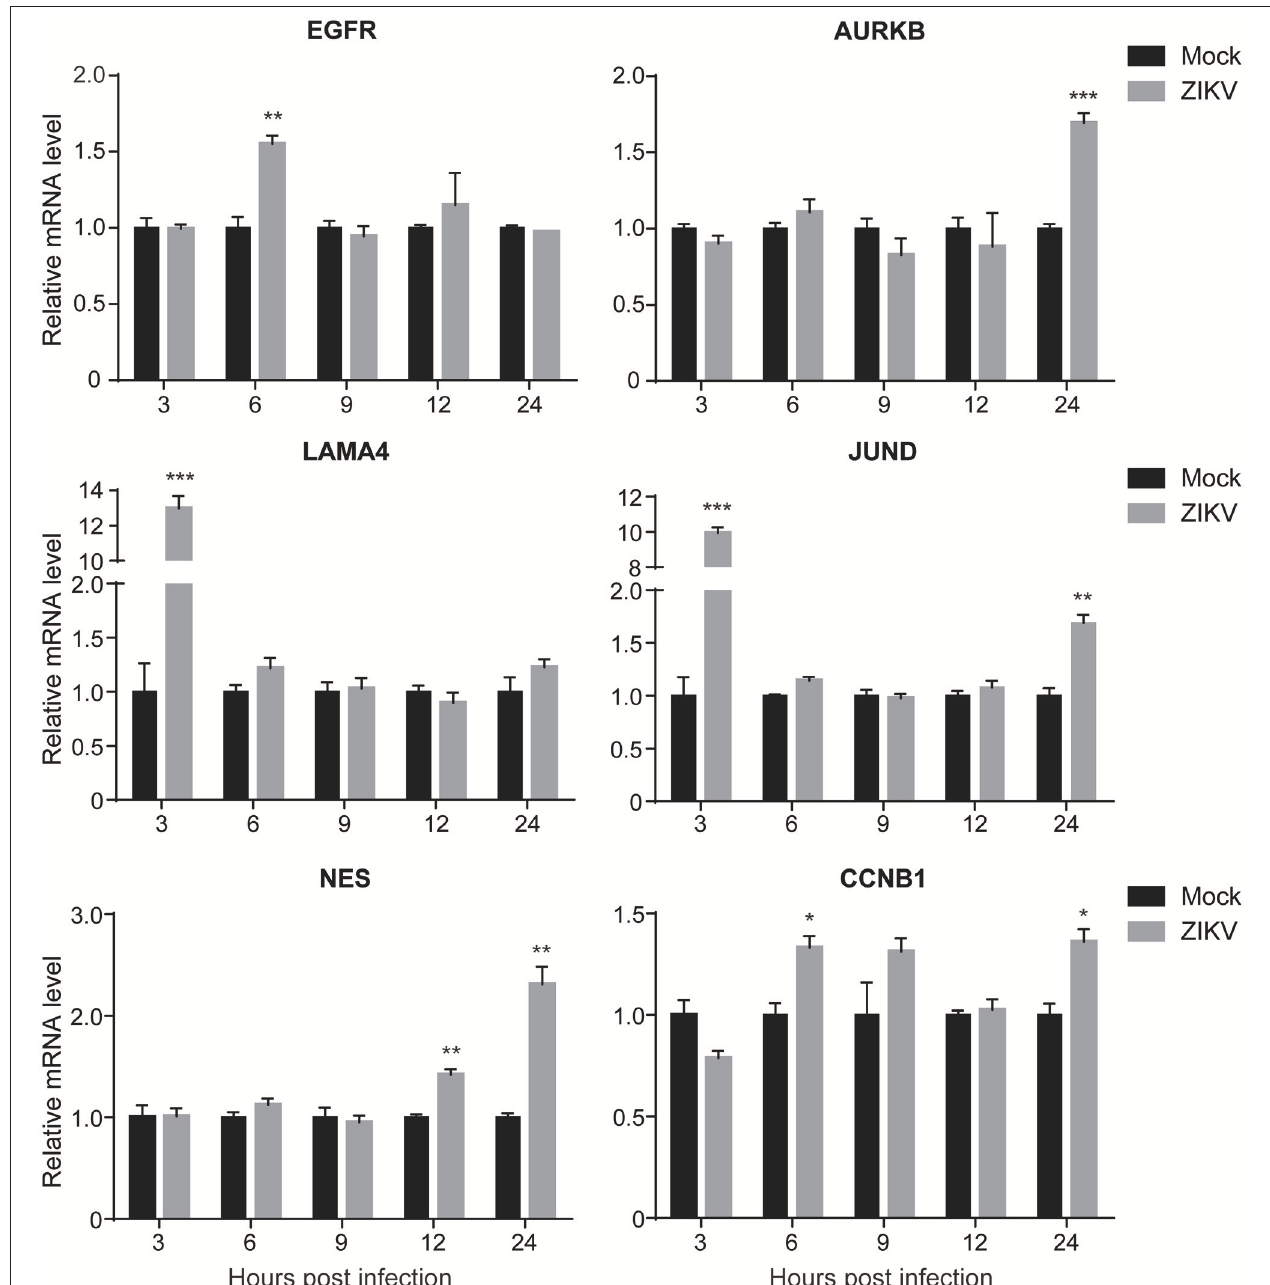
FIGURE 4 | The transcriptional levels of target genes in ZIKV-infected NPCs. NPC monolayers were infected with ZIKV at an MOI of 3.0 or mock infected and RNA was prepared at 3, 6, 9, 12, and 24 hpi. Expression levels of EGFR, AURKB, LAMA4, JUND, NES and CCNB1 were analyzed by qRT-PCR, normalized to GAPDH, and expressed as relative mRNA levels to mock-infected NPCs. Each experiment was conducted in triplicate. Results shown represent the means from three independent experiments. Data were analyzed by one-way ANOVA; * p < 0.05; ** p < 0.01; *** p < 0.005.